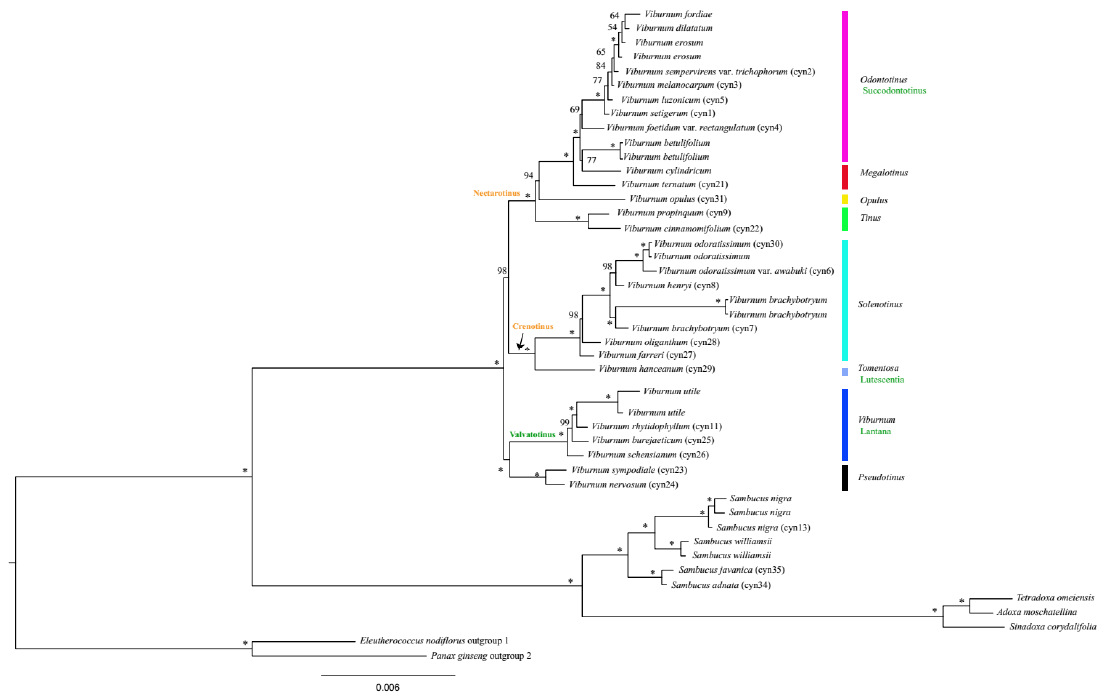
Figure 5. Phylogenetic relationships among Viburnum and Sambucus species inferred from the complete cp genome sequence dataset based on maximum likelihood (ML) method. Numbers above the nodes represent ML bootstrap values, and “*” indicates 100% support values in ML. Clade names (in the right) marked in black represent previously published names under the ICN (International Code of Nomenclature) that are here converted to phylogenetic names. Those in green (in the right and along a branch) represent names proposed by Winkworth and Donoghue [16] and Clement and Donoghue [17]. Clade names in orange (along a branch) represent names proposed by Clement et al. [19].